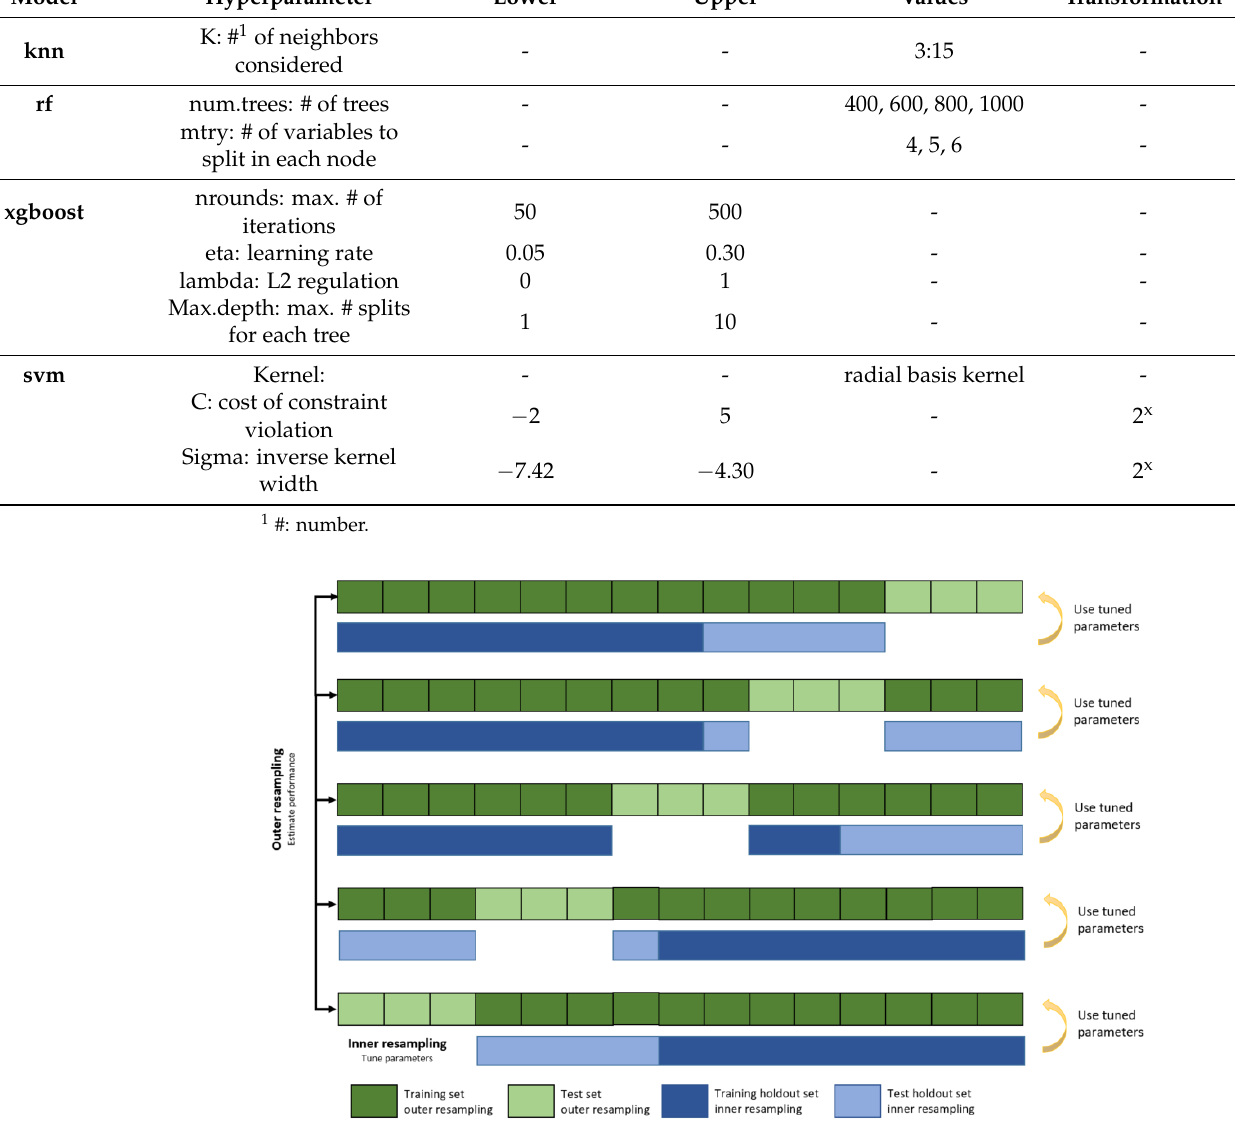
Figure 3. Representation of the nested cross-validation approach for tuning and measuring the performance of the chosen ML models based on [56]. Within each of the 5 outer folds, a holdout strategy to tune the hyperparameters is carried out. The best found hyperparameters are then evaluated on the test set of the outer fold. Table 2. Hyperparameter configuration space for model tuning. The table shows the lower and up- per bounds of each ML model ’ s hyperparameters we tuned using iterated F-racing. The knn and rf are tuned using a grid search over the hyperparameter values shown in column “ Values ” . The val- ues of the hyperparameters C and sigma of the svm have been transformed for the tuning process by the transformation function shown in the last column of the table.